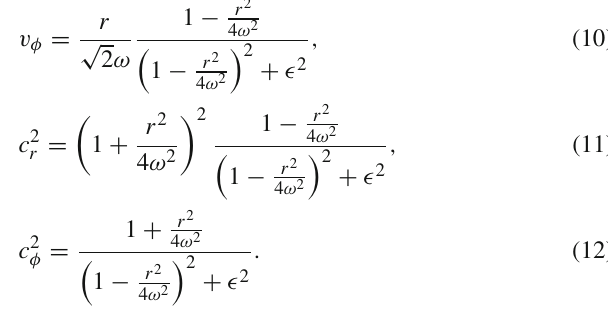
the regularized Gödel geometry introduced in the text, also for ω = 1 and for the regularization parameter (cid:11) = 0 . 01. Whereas the graphics on the left panels all blow up at r = r C , the ones in the right panels are smooth everywhere. All functions are normalized to a maximum value of 1 in the